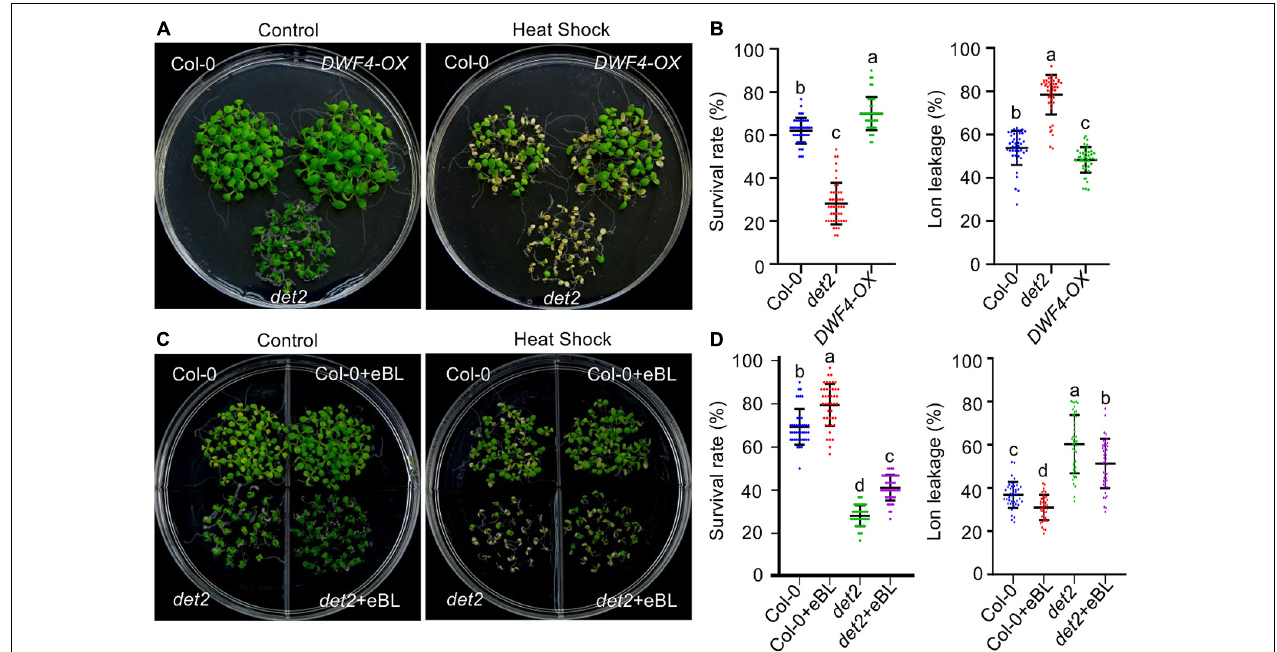
FIGURE 1 | Brassinosteroid regulates acquired thermotolerance in Arabidopsis . (A,C) The phenotypes of HS-treated and untreated plants. One-week-old seedlings grown on 1/2 MS agar medium supplemented with or without 0.1 µ M eBL under LD conditions at 22 ◦ C were exposed to 37 ◦ C for 1 h. After recovering at 22 ◦ C for 2 h, the seedlings were exposed to 22 ◦ C (control) or 45 ◦ C (HS) for 3 h and then allowed to recover at 22 ◦ C for 3 days before being imaged. (B,D) Quantification of the survival rates of and ion leakage from the plants shown in panels (A,C) . Error bars indicate the mean ± standard deviation (SD). Statistically significant differences are indicated by different lowercase letters ( p < 0.05, one-way